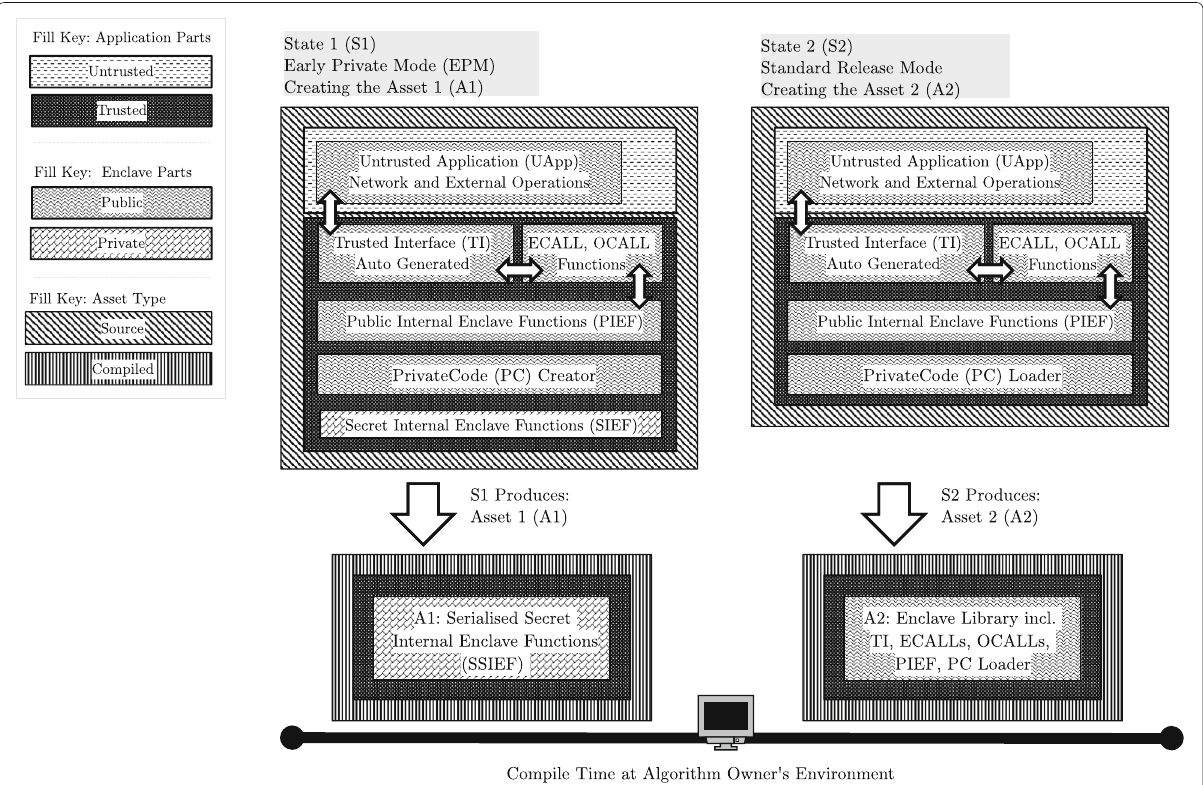
Fig. 7 The Early Private Mode (EPM) runs before releasing the enclave binary. It creates the Asset 1 (A1) that includes the Serialised Secret Internal Enclave Functions (SSIEF). The standard release mode in State 2 (S2) creates the enclave binary including the Private Code